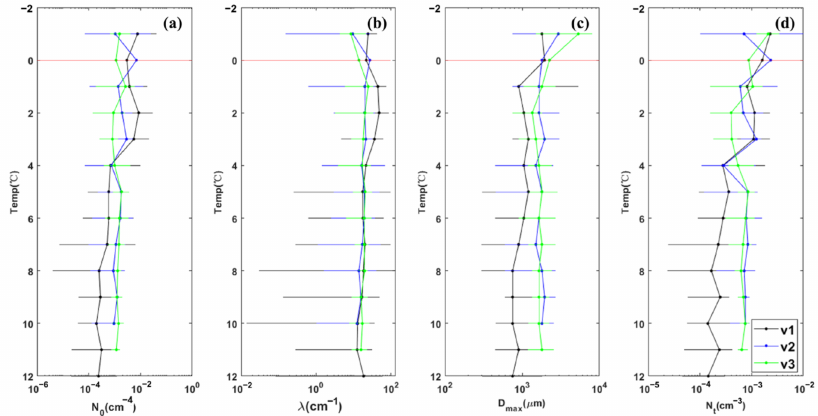
Figure 15. The parameters of 21 May 2018, ( a ) intercept ( N 0 ), ( b ) slope ( λ ), ( c ) the maximum particle size ( D max ), ( d ) the total particle concentration ( N t ) The red line is the 0 ◦ C layer.